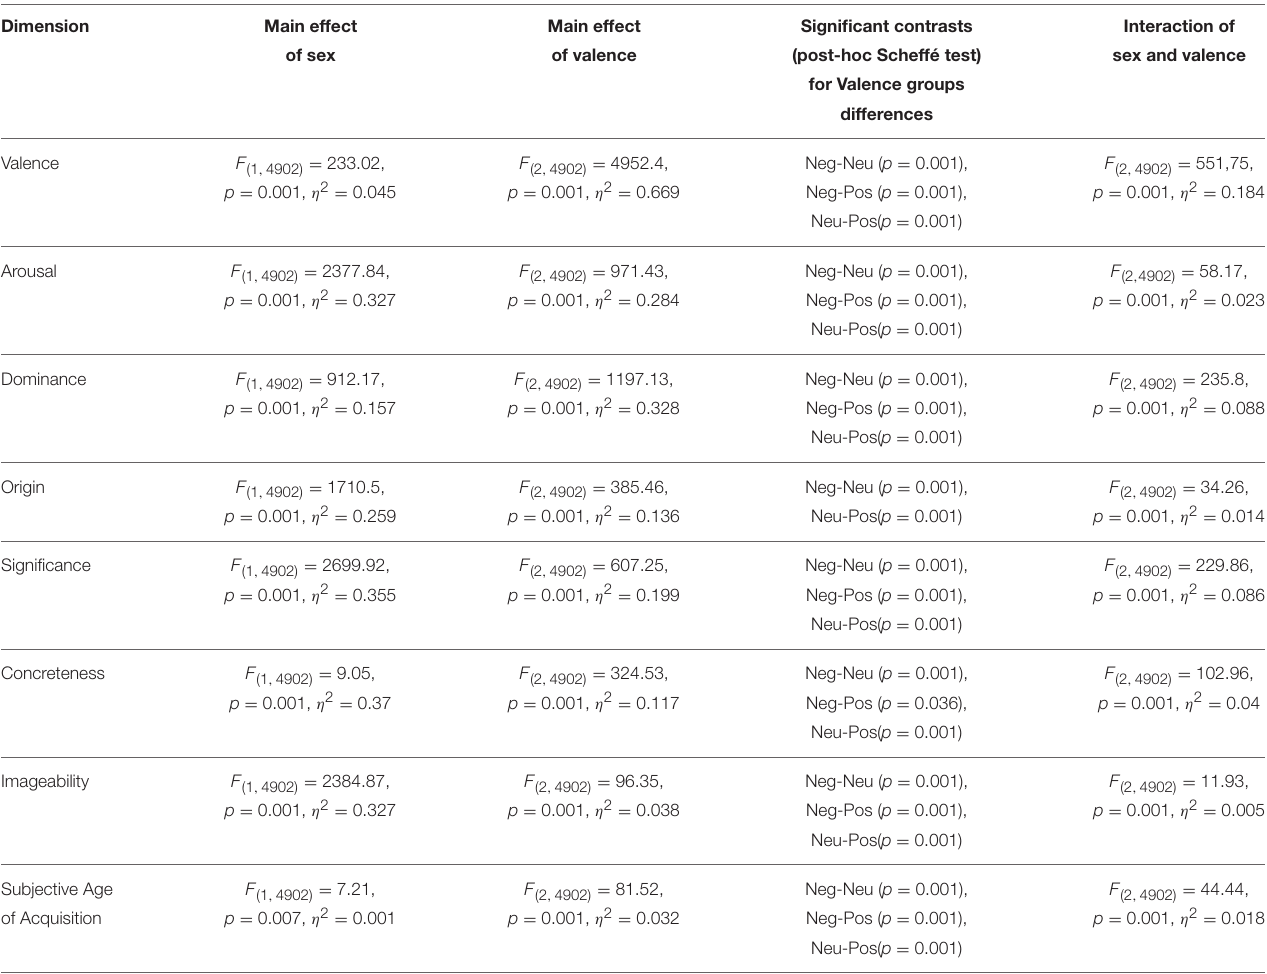
TABLE 5 | Valence, Sex, and interaction of valence and Sex impact on each analyzed dimension.